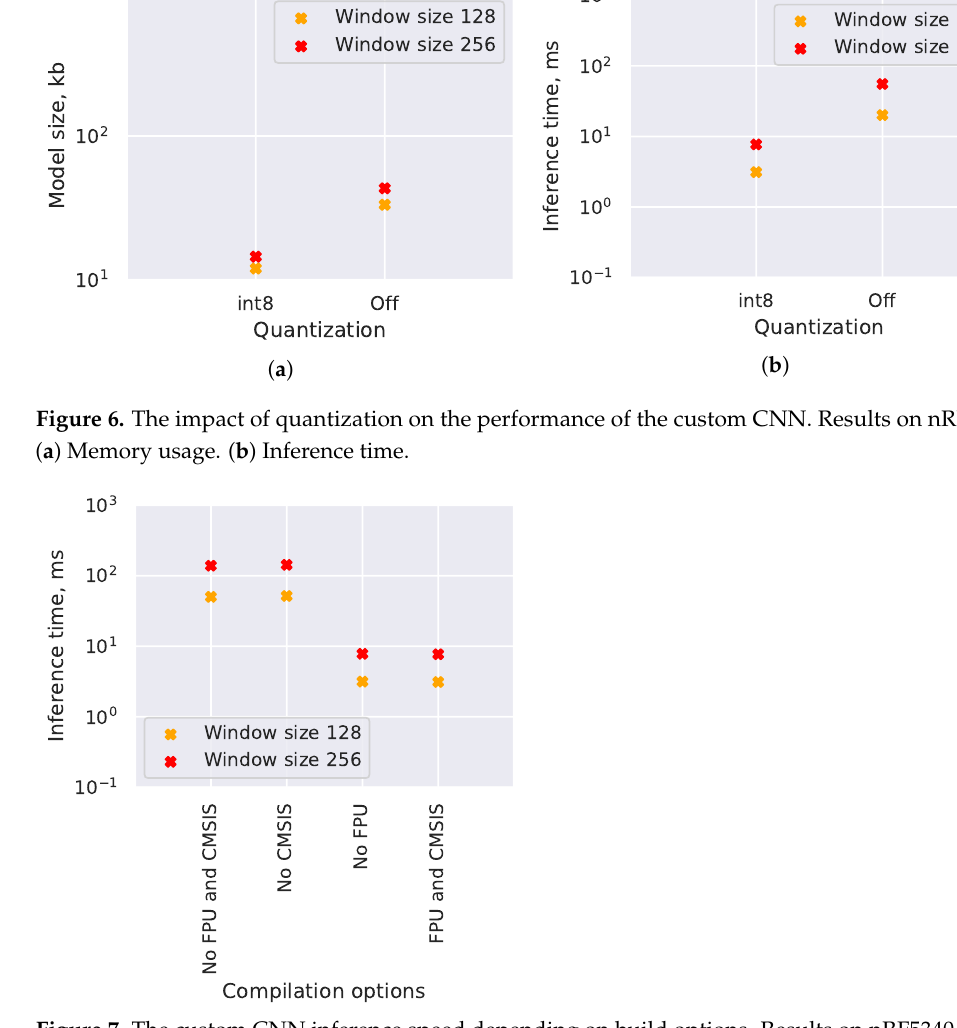
Figure 7. The custom CNN inference speed depending on build options. Results on nRF5340.